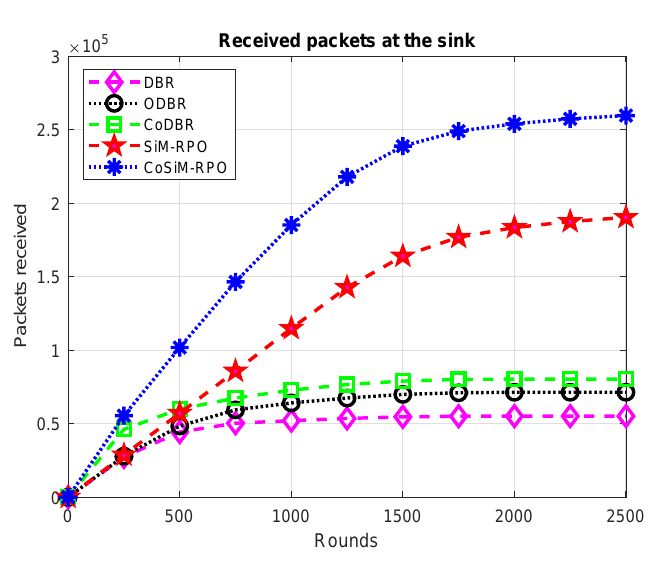
Figure 7. Remaining energy.